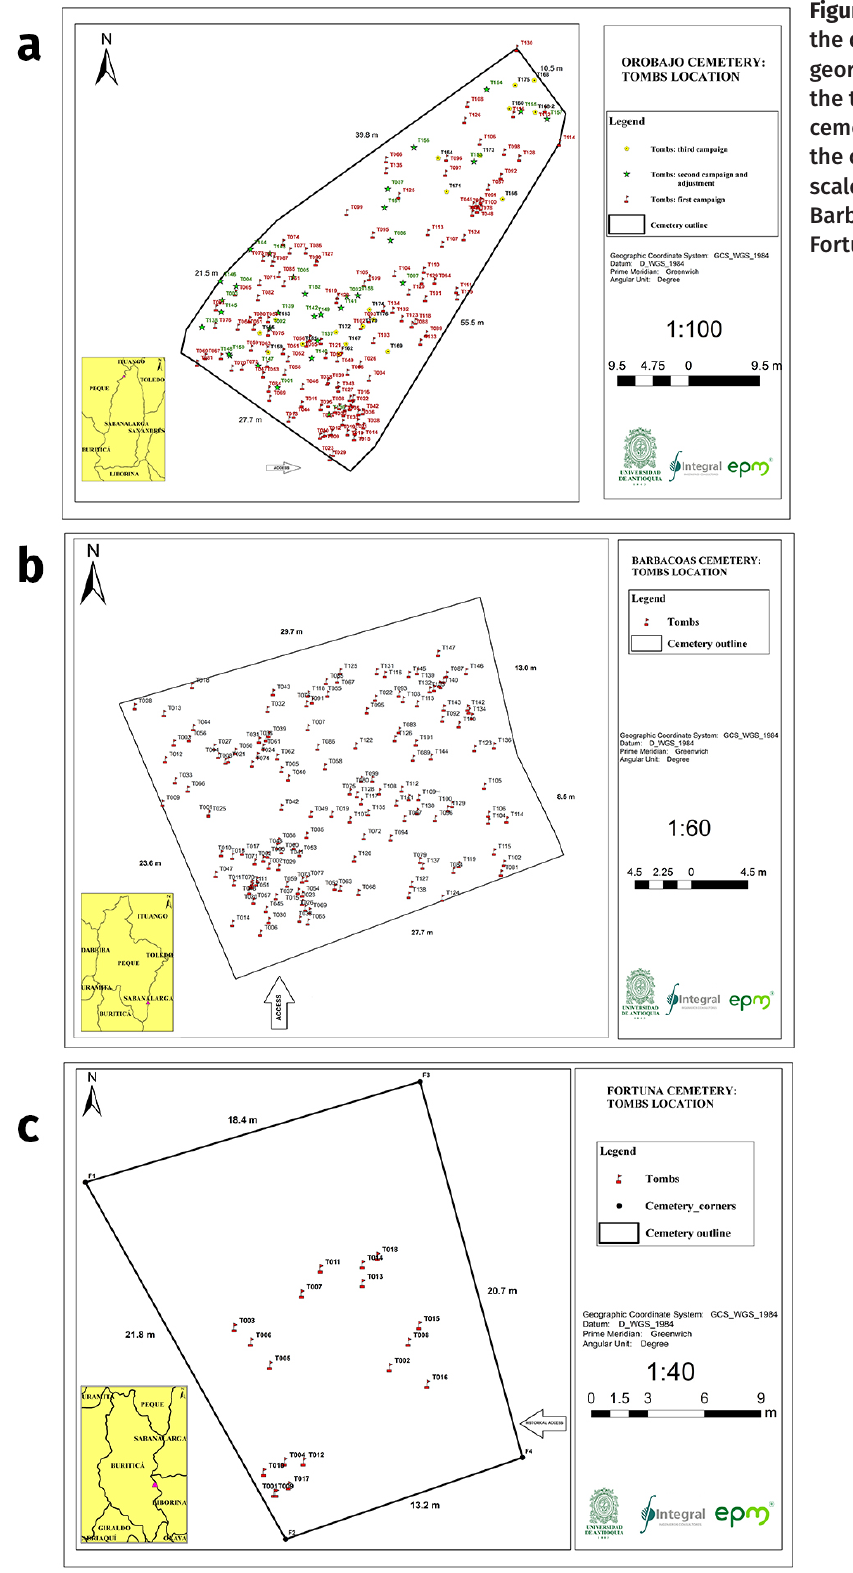
Figure 5. Maps of the distribution and georeferencing of the tombs in the cemeteries and the corresponding scale. a) Orobajo, b) Barbacoas and c) La